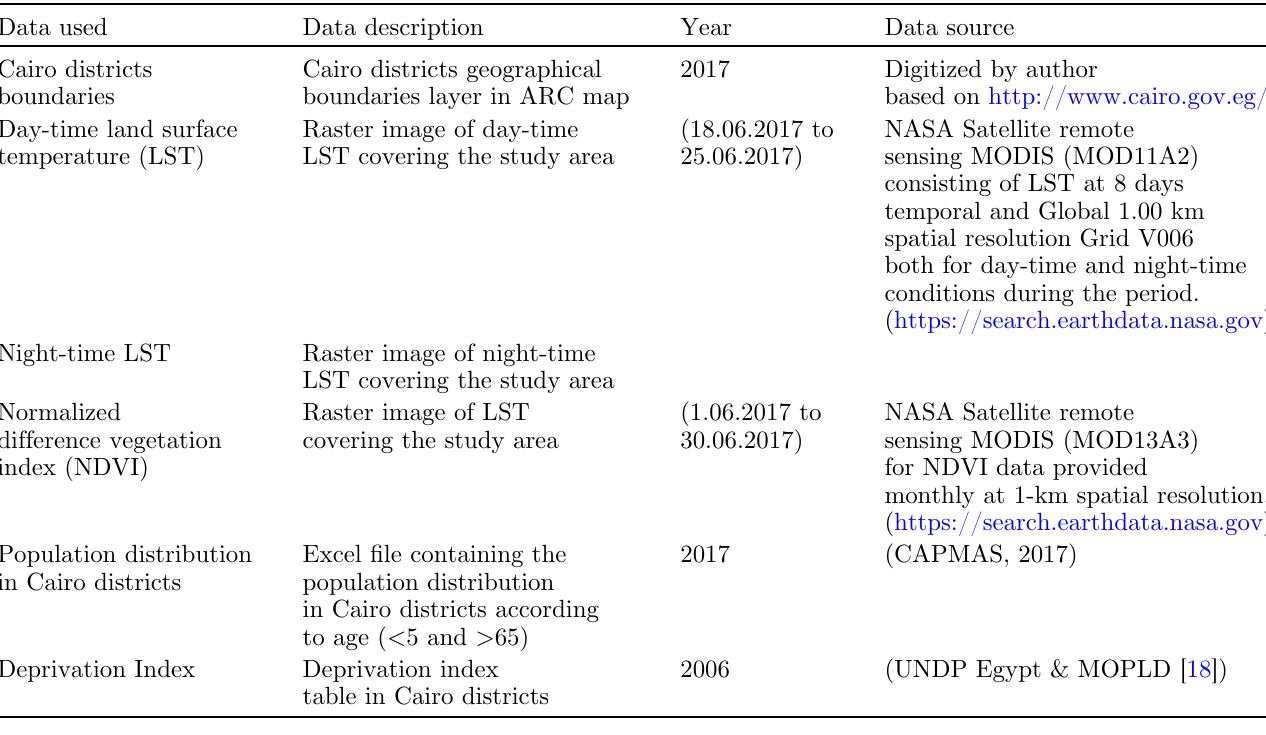
Table 2. Description of the data used in the study.